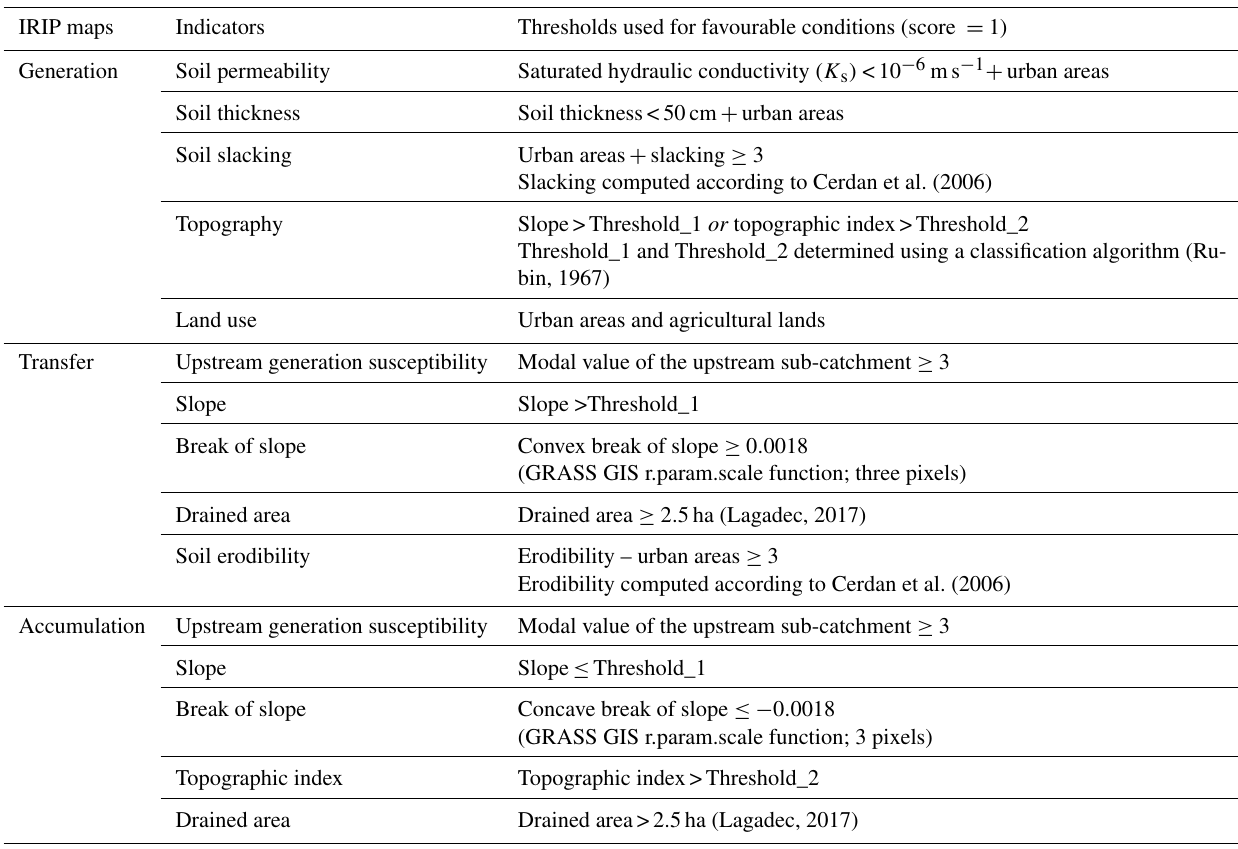
Table 1. Parameterization of the IRIP model for the case study. The table provides values of the thresholds used for each indicator when condition is favourable (score of